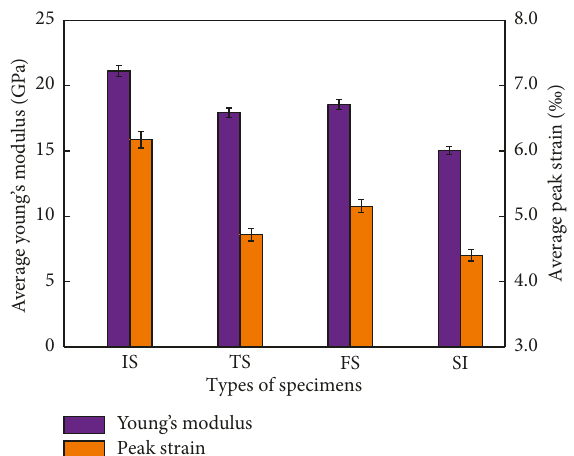
Figure 5: Deformation parameters of different specimens under uniaxial compression.